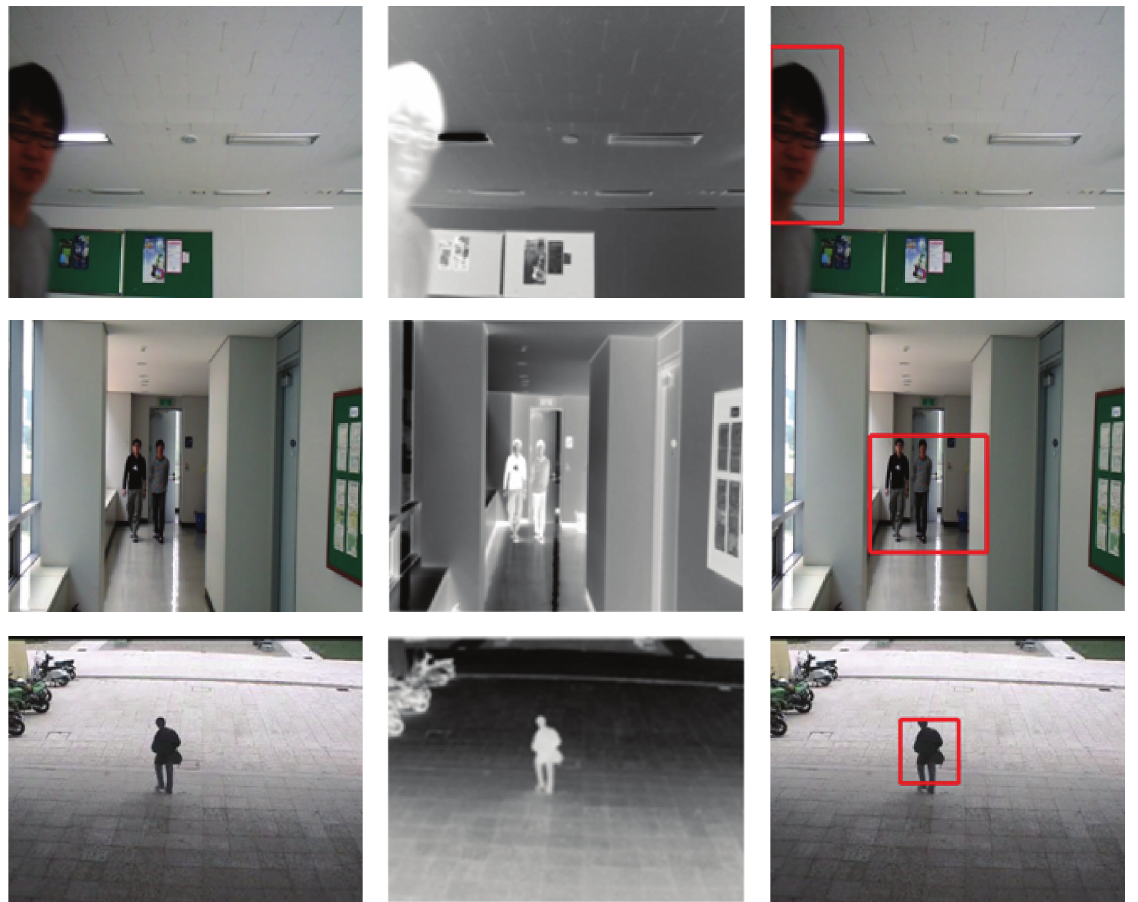
Figure 12: Videos (5), (6), and (7): results using Gaussian spatial model by coalescing Laplacian of Gaussian (LoG) filter and Gaussian filter for different videos.